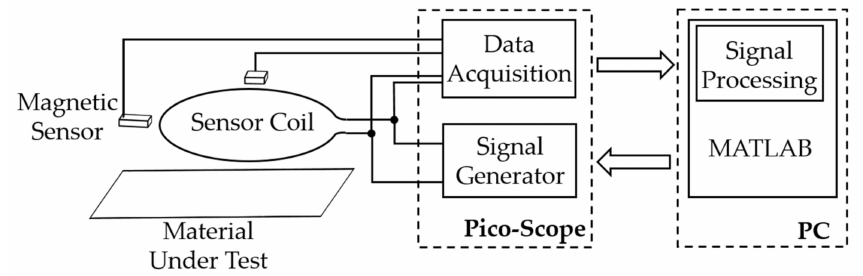
Figure 3. Block diagram of a sensor